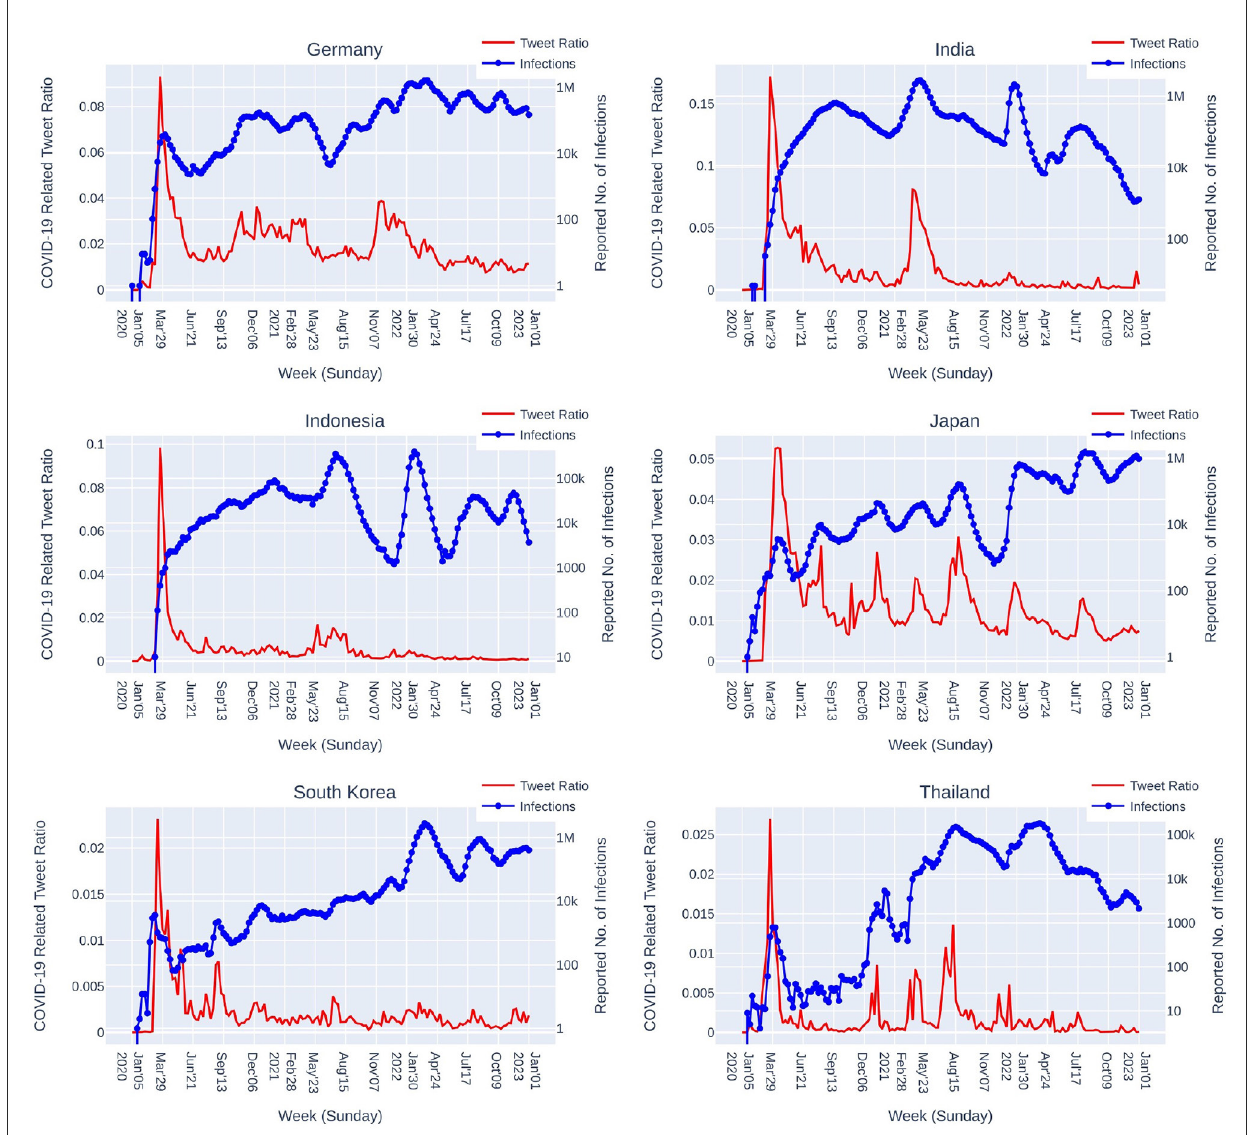
FIGURE8 COVID-19 related social media (Twitter) reaction depicted by the ratio of weekly total tweet counts of “COVID-19 related tweets” vs. “all tweets” since January 2020. The reported number of infections is plotted in weekly sum.